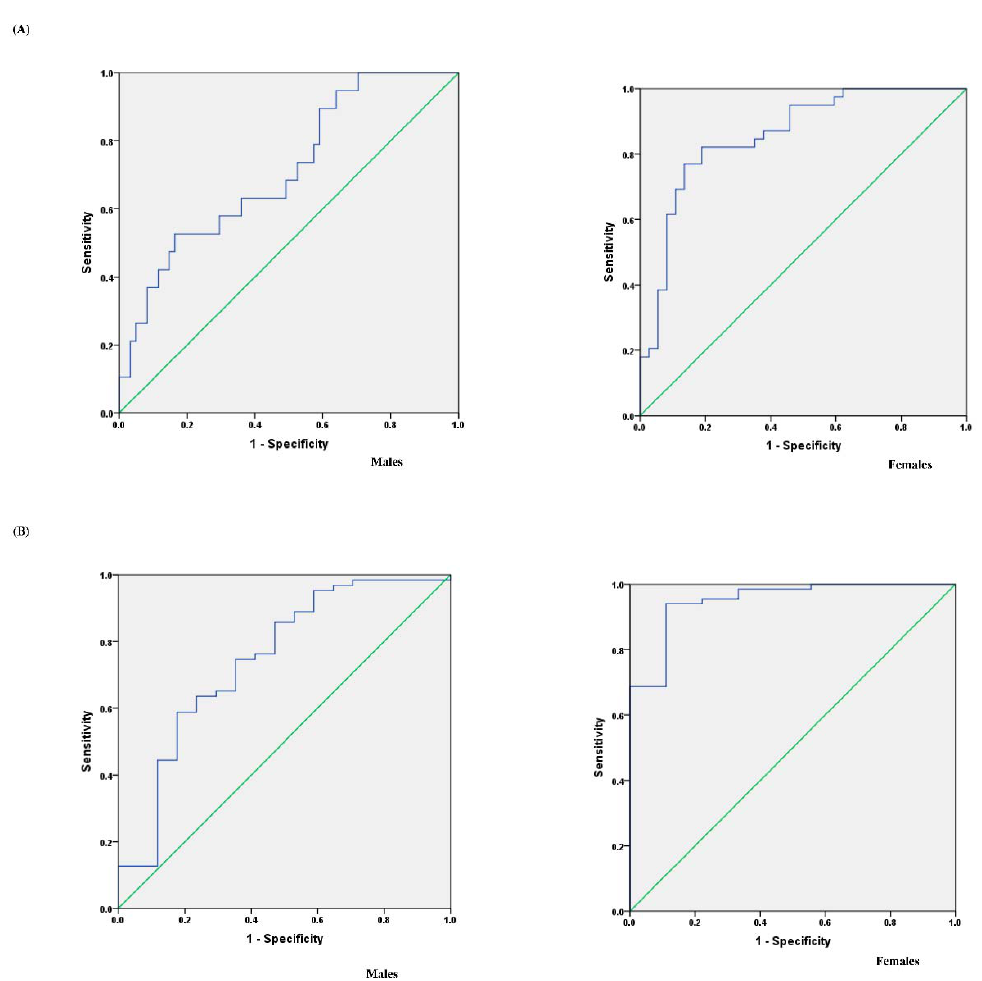
Figure 3. Receiver operating characteristic curve (ROC) analysis curve of the total water intake for assessing optimal hydration and assessing dehydration. ( A ) ROC for assessing optimal hydration in males and females; ( B ) ROC for assessing dehydration in males and females.